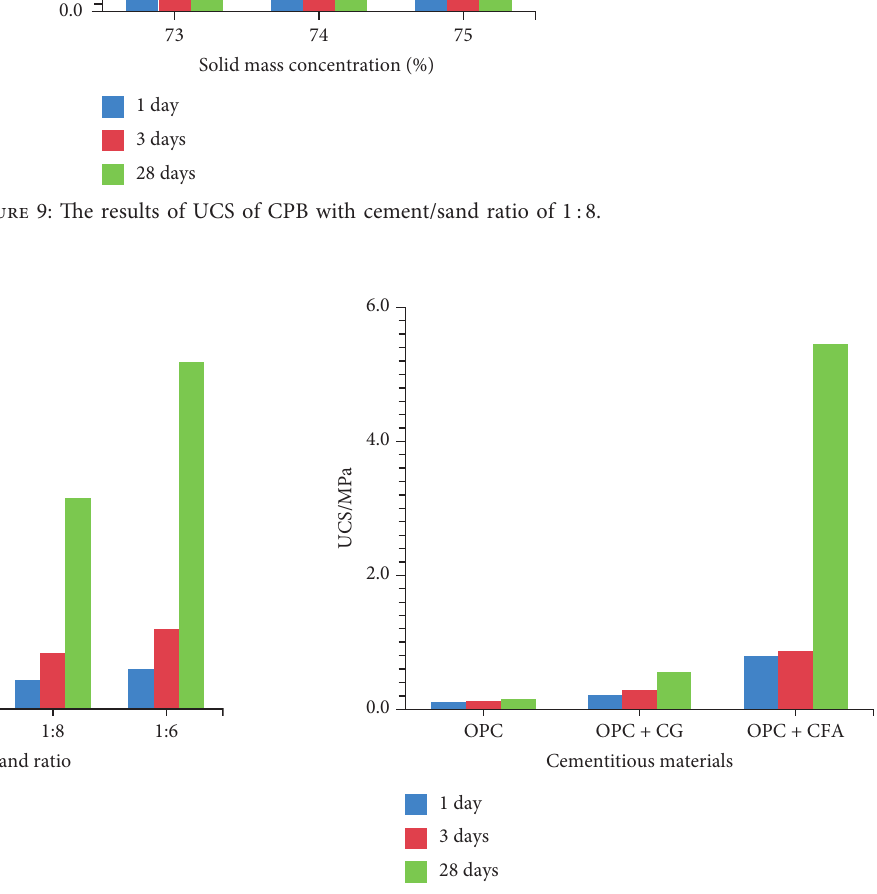
Figure 10: The results of UCS of CPB with solid mass concen- tration of 74%.